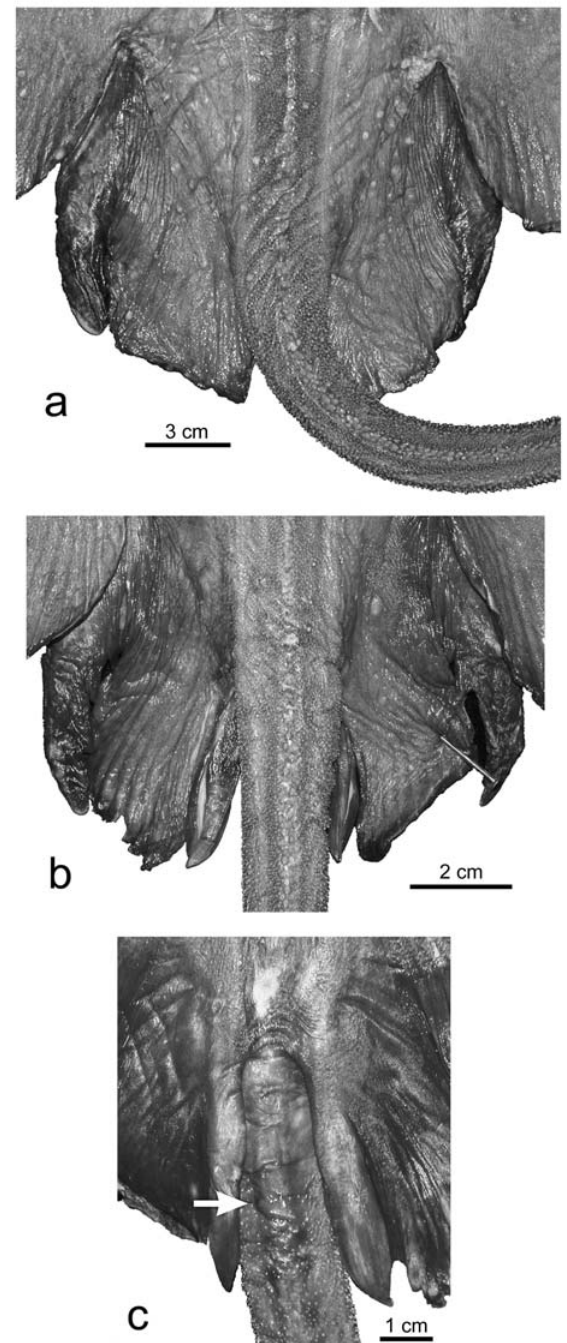
Fig. 6. Detail of (a) dorsal, and (b) dorsal and (c) ventral pel- vic fins and tail base of Malacoraja obscura , n. sp.: (a) holo- type (MNRJ 28289, 680 mm TL); (b) and (c) paratype (MNRJ 28290, 505 mm TL). Note characteristic whitish spots in (a). Arrow in (c) indicates posterior extent of region devoid of denticles on tail